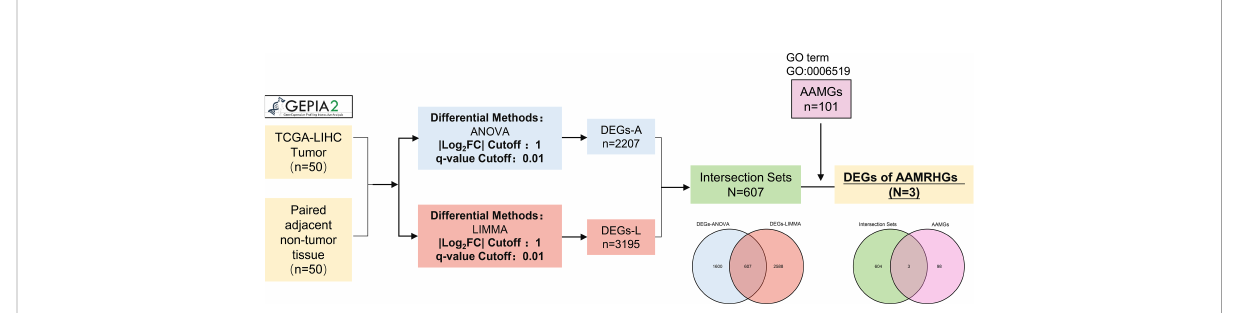
FIGURE 1 Flow chart of identifying target genes for study. GEPIA2 picture is from